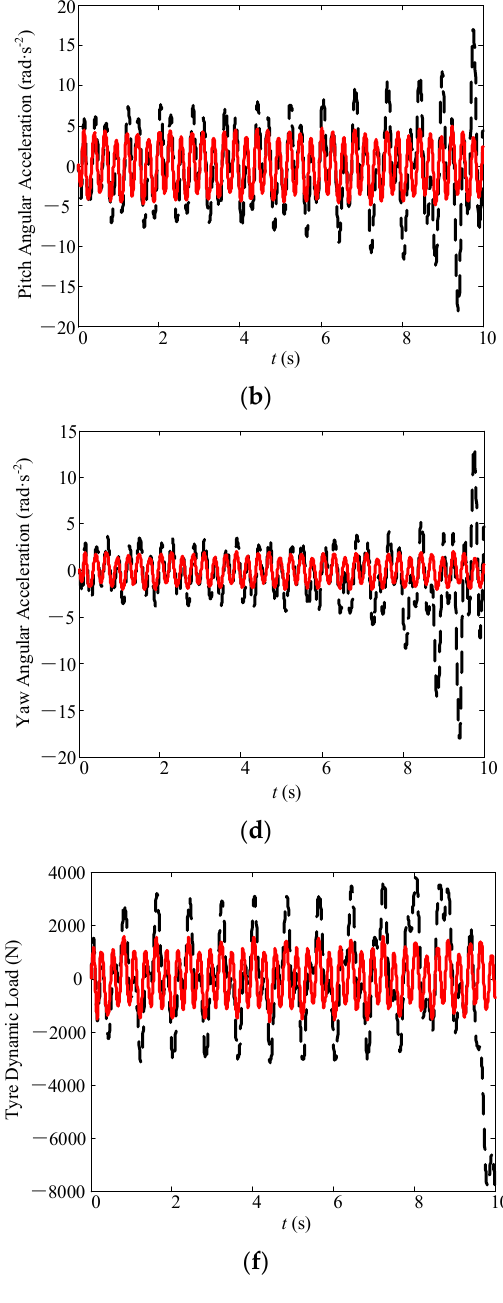
Figure 12. Dynamic characteristics under coupled road excitation: ( a ) centroid acceleration; ( b ) pitch angular acceleration; ( c ) roll angular acceleration; ( d ) Yaw angular acceleration; ( e ) suspension working space; ( f ) tyre dynamic load.